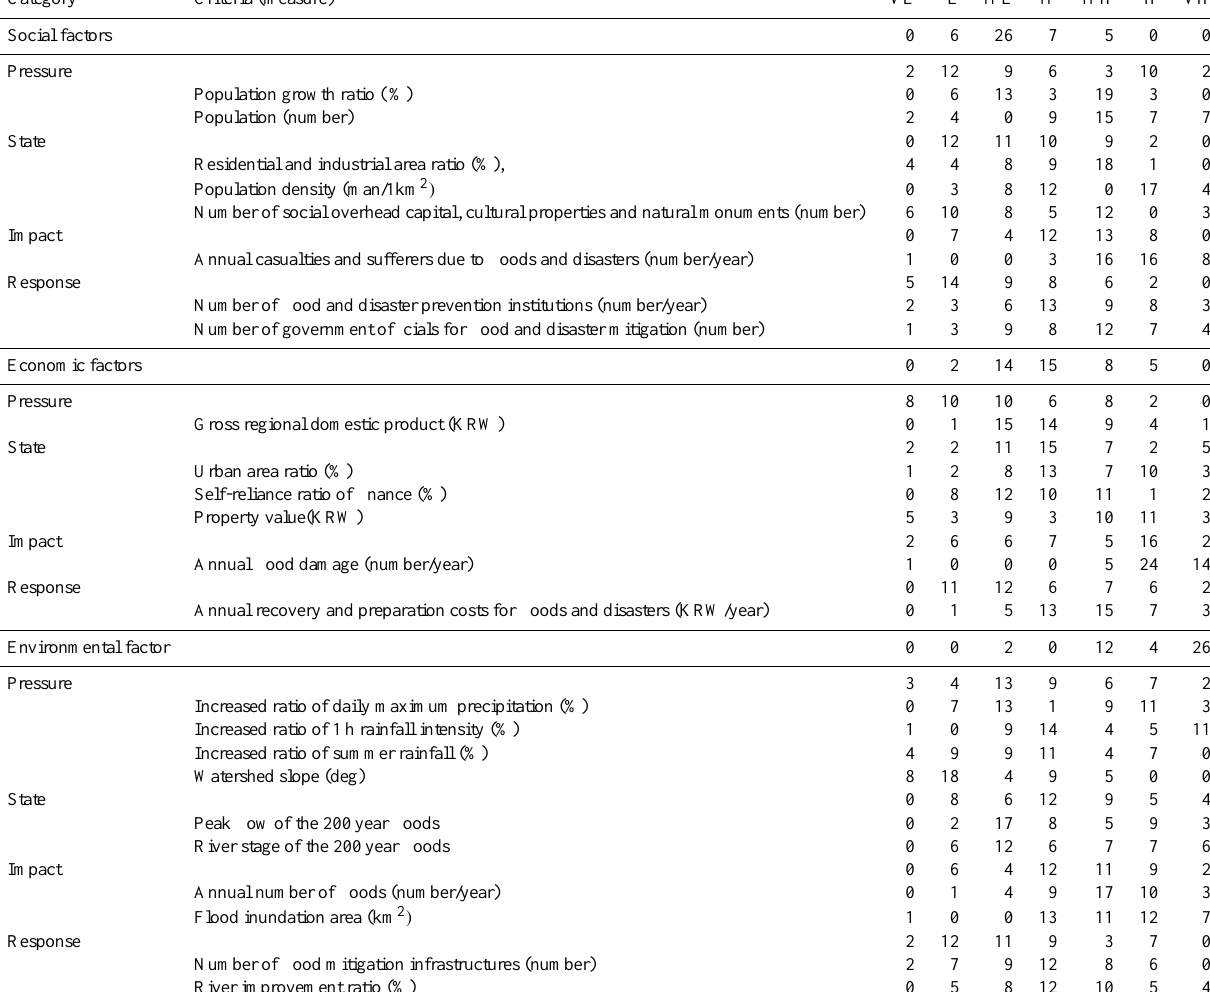
Table 1. Criteria for flood vulnerability and summary of weighting. Category